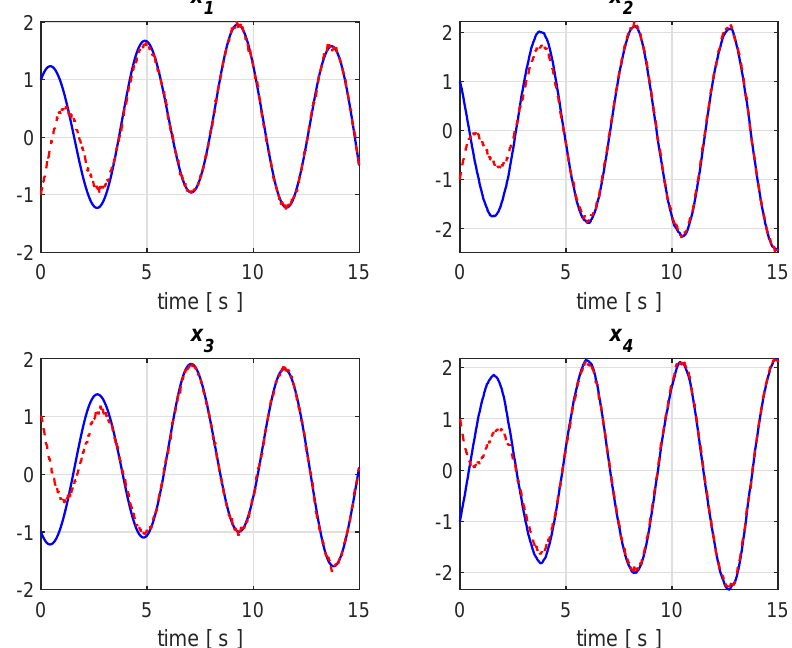
Figure 2. Simulation result with zero-mean, truncated Gaussian noises w i with variance equal to 1, i = 1,2,3,4 with states and estimated states in blue and red,